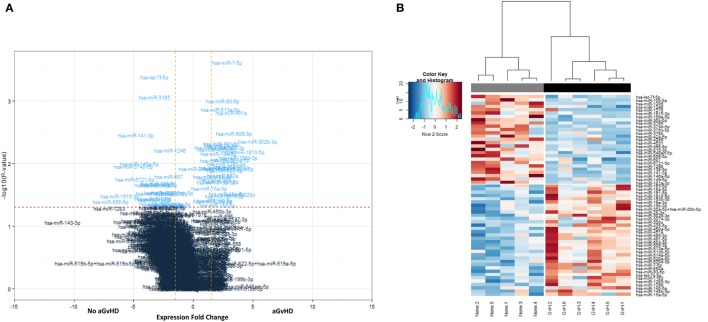
NanoString-detected fold changes (FCs) in microRNA quantity between acute graft-versus- host disease (aGvHD) vs. no aGvHD patients. Eleven allohematopoietic stem cell transplantation patient serum samples (six aGvHD and five no aGvHD) were included in the final data set for microRNA expression assessment (n = 799) using the NanoString microRNA panel. (A) Volcano plot to show the relationship between FC and significance between the two groups. A FC comparison was made comparing aGvHD to no aGvHD. The horizontal dashed line indicates cutoff for significance p < 0.05 (−log10 p > 1.3) and the vertical lines for FC ≥ 1.5/≤−1.5. (B) Heatmap showing hierarchical clustering of significantly differentially expressed microRNAs (p < 0.05, n = 61), based on normalized digital expression counts, in serum samples between patients with aGvHD vs. no aGvHD. Each column represents an individual patient. Relative expression changes are indicated by the color scale (red: high; blue: low). No aGvHD (none) cases are indicated in gray, while aGvHD cases (GvH) are indicated in black.